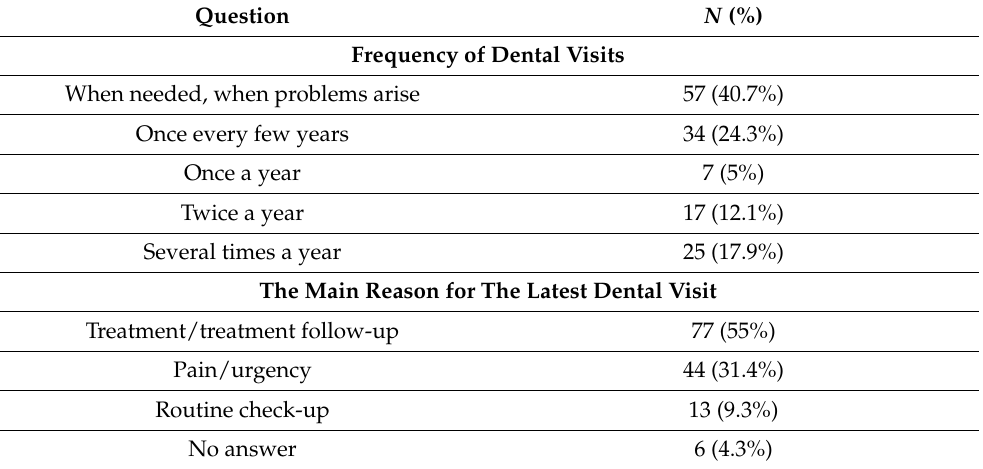
Table 2. Patients’ habits related to dental